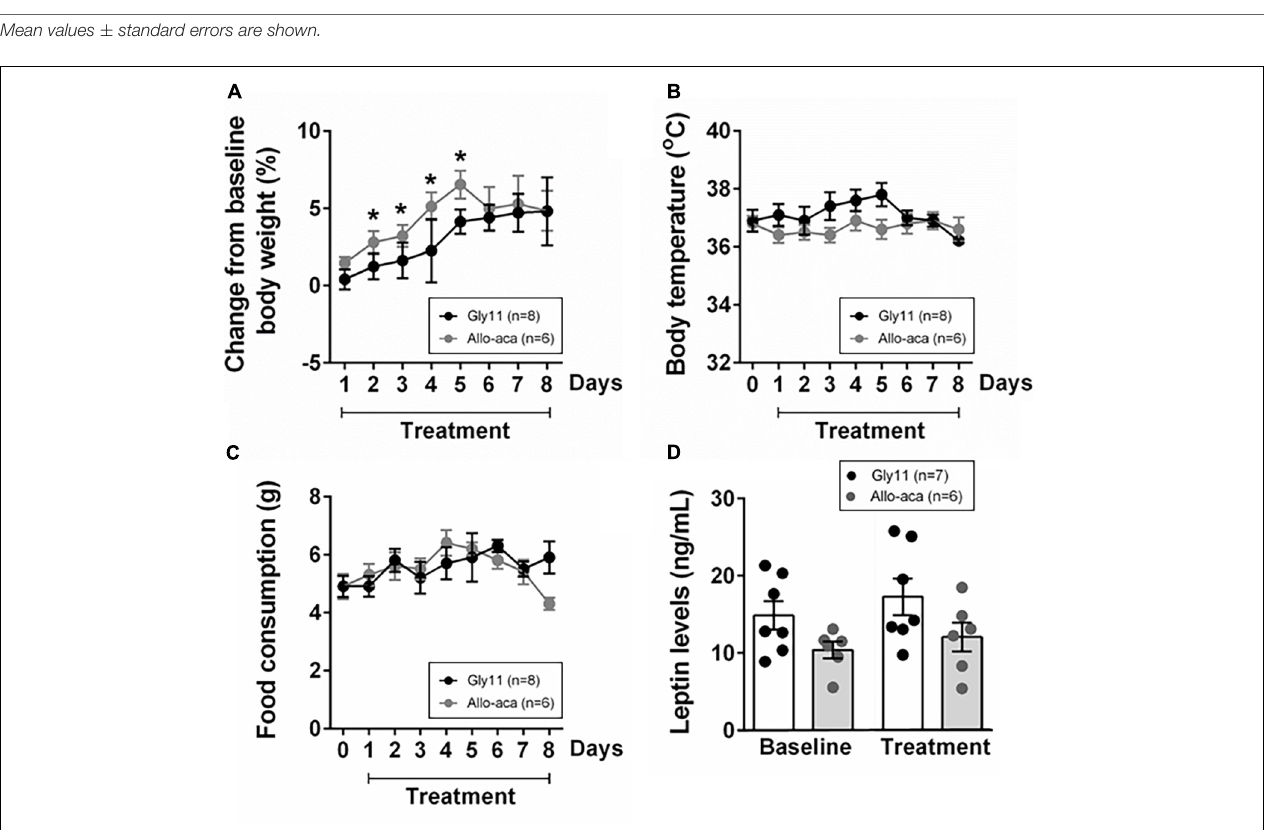
FIGURE 1 | Leptin receptor blocker Allo-aca did not affect (A) body weight, (B) body temperature, (C) food consumption, and (D) plasmatic levels of leptin in NZO mice. (A) Lines represent the percentage of change in the body weight throughout the 8 days of treatment compared to baseline. (B,C) Line graphs represent the comparisons to baseline (day 0) and among the 8 days of treatment with either Allo-aca or control peptide Gly11. Mean values ± standard errors are shown. Mixed regression model. *Significant increase in body weight until day 5 of treatment in both groups ( P < 0.05).